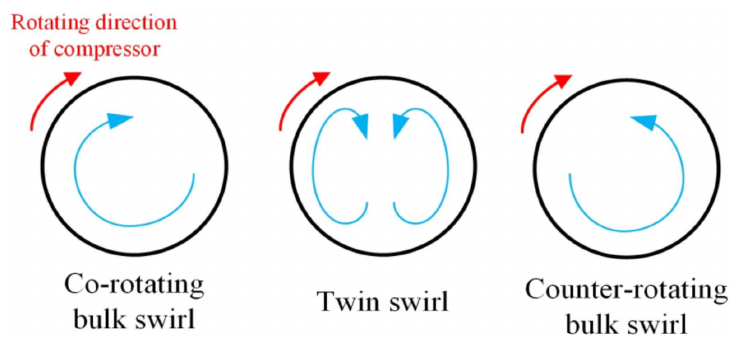
Figure 2. Schematic of three types of swirl flow